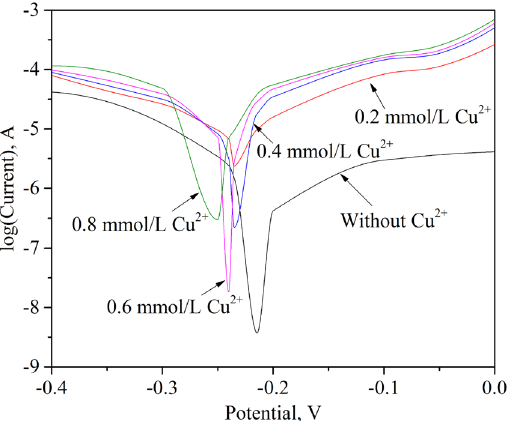
Figure 5: Tafel plots of gold dissolution with di ff erent copper